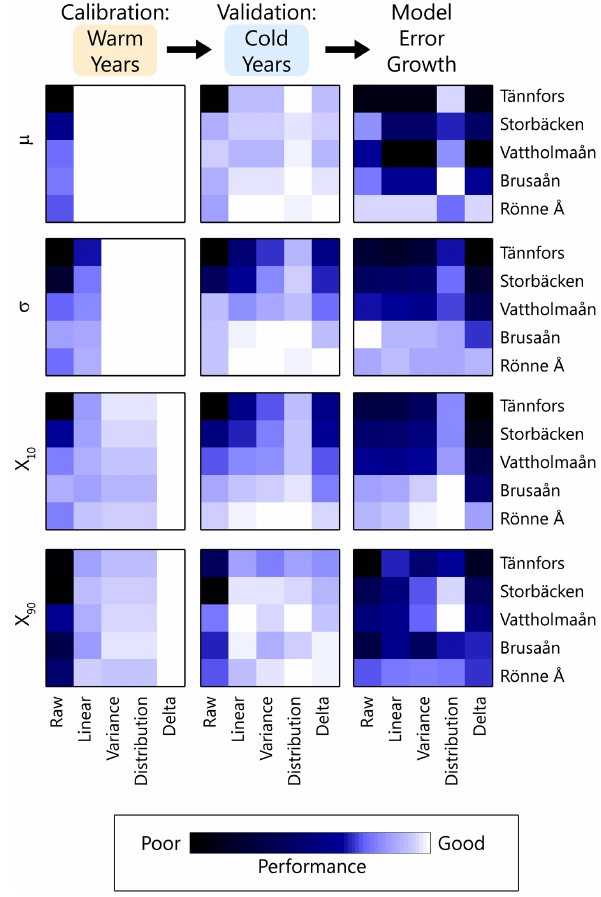
Fig. 8. Normalized temperature model errors (different shades of blue) of 4 different statistical diagnostics (panel rows) for calibra- tion period (left panel column) and validation period (central panel column). The model error growth, i.e., the absolute difference be- tween model errors in validation and calibration period, is shown as well (right panel column). Each panel displays model error infor- mation depending on the 5 applied bias correction methods ( x axis) and the 5 catchment locations ( y axis). The figure is based on case- 2 evaluation with calibration on warm years and validation on cold